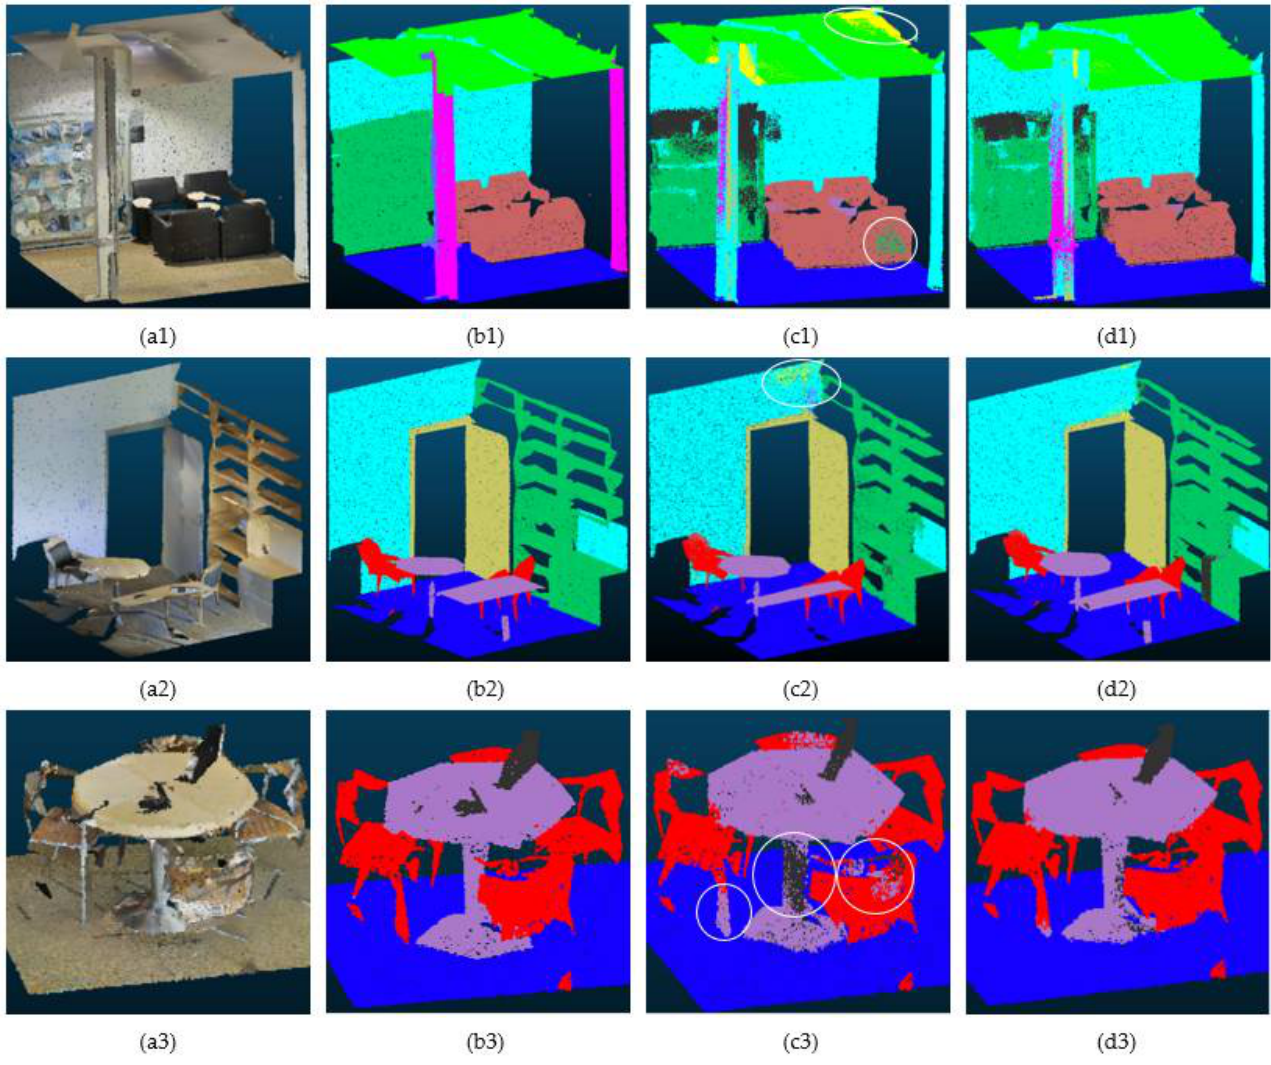
Figure 6. 3D semantic segmentation of S3DIS. ( a1 ) Data of Scene 1; ( b1 ) Ground Truth; ( c1 ) PAConv; ( d1 ) PIIE-DSA-net; ( a2 ) Data of Scene 2; ( b2 ) Ground Truth; ( c2 ) PAConv; ( d2 ) PIIE-DSA-net; ( a3 ) Data of Scene 3; ( b3 ) Ground Truth; ( c3 ) PAConv; ( d3 ) PIIE-DSA-net.